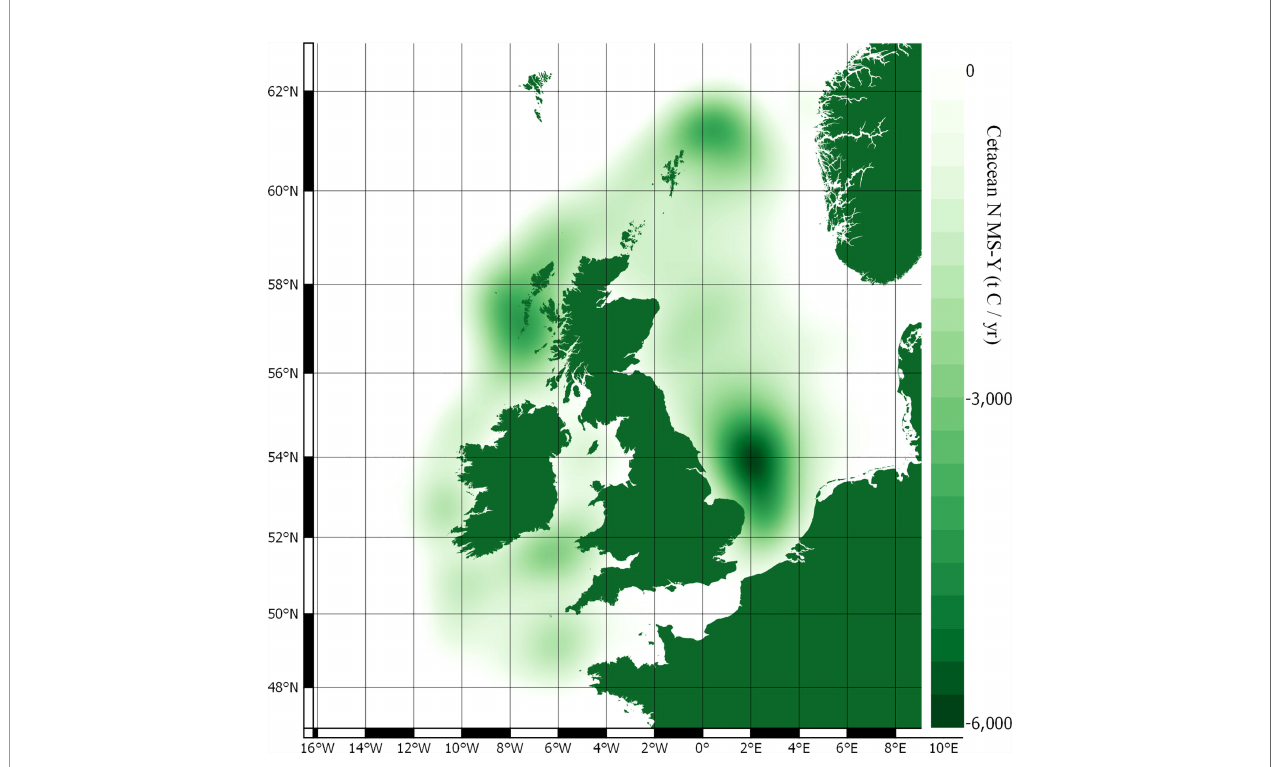
FIGURE 5 | Cetacean driven N MS-Y carbon fl uxes.